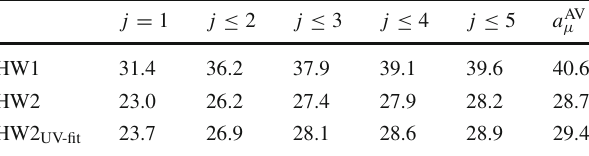
Table 3 The contribution of the infinite tower of axial vector mesons to a AV μ in multiples of 10 − 11 obtained in Ref. [38]. The entries j ≤ n give the contribution of the first n axial vector multiplets